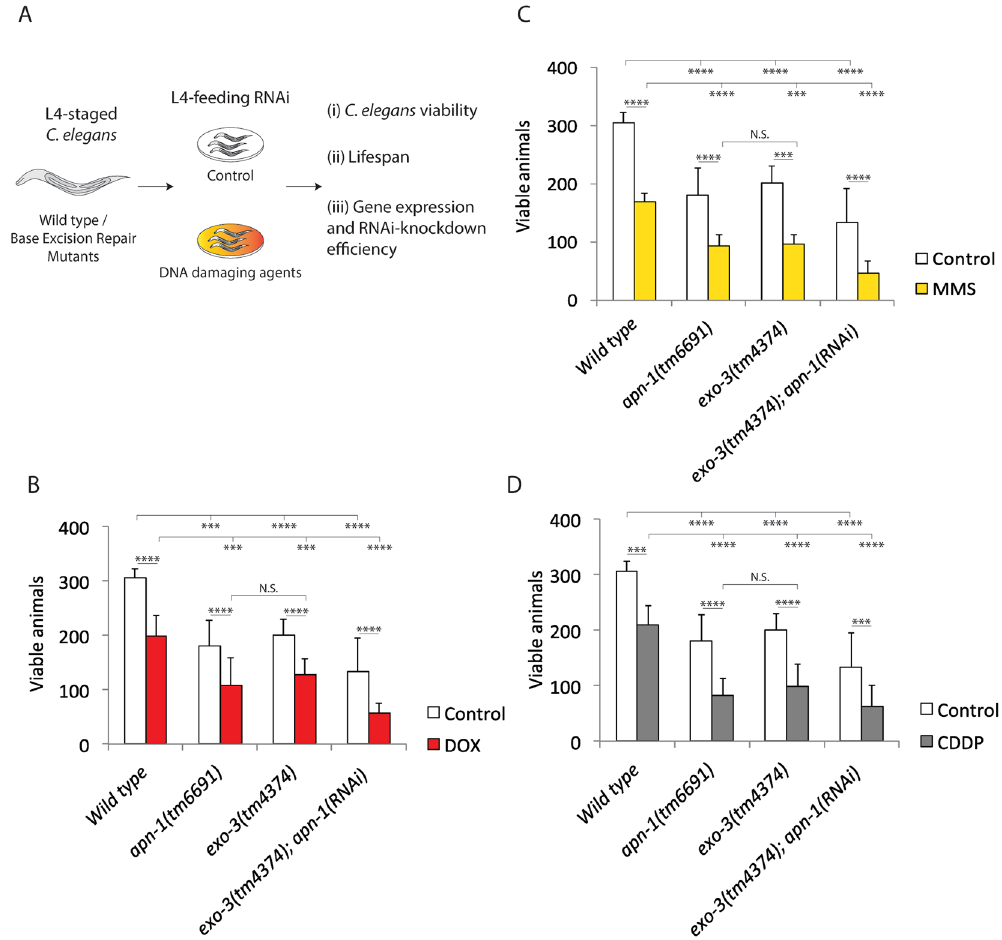
Figure 1. C. elegans mutants deficient in both APN-1 and EXO-3 are hypersensitive to DOX-, MMS- and CDDP-induced DNA lesions. ( A ) Scheme of the experimental design. ( B , C and D ), Brood size analyses of the indicated genotypes. The data are the mean ± S.D. of three independent experiments ( n = 10 monitored for 3 days). Control; Wild type: 305 ± 17; apn-1(tm6691) : 181 ± 47; exo-3(tm4374) : 201 ± 29; exo-3(tm4374); apn-1(RNAi) : 134 ± 61. Exposed to drugs; ( B ) DOX 100 μ M: Wild type: 199 ± 37; apn-1(tm6691) : 108 ± 50; exo-3(tm4374) : 128 ± 29; exo-3(tm4374); apn1(RNAi) : 57 ± 18. C, MMS 0.25 μ M: Wild type: 168 ± 15; apn- 1(tm6691) : 93 ± 20; exo-3(tm4374) : 97 ± 15; exo-3(tm4374); apn1(RNAi) : 46 ± 21. ( D ) CDDP 100 μ M: Wild type: 210 ± 33; apn-1(tm6691) : 82 ± 31; exo-3(tm4374) : 98 ± 41; exo-3(tm4374); apn1(RNAi) : 63 ± 38. Error bars represent the S.D. Unpaired two-tail t-test *** P < 0.01; **** P < 0.0005 were considered to be statistically significant. N.S. = Non-Significant. DOX, doxorubicin; MMS, methyl methanesulfonate; and CDDP,